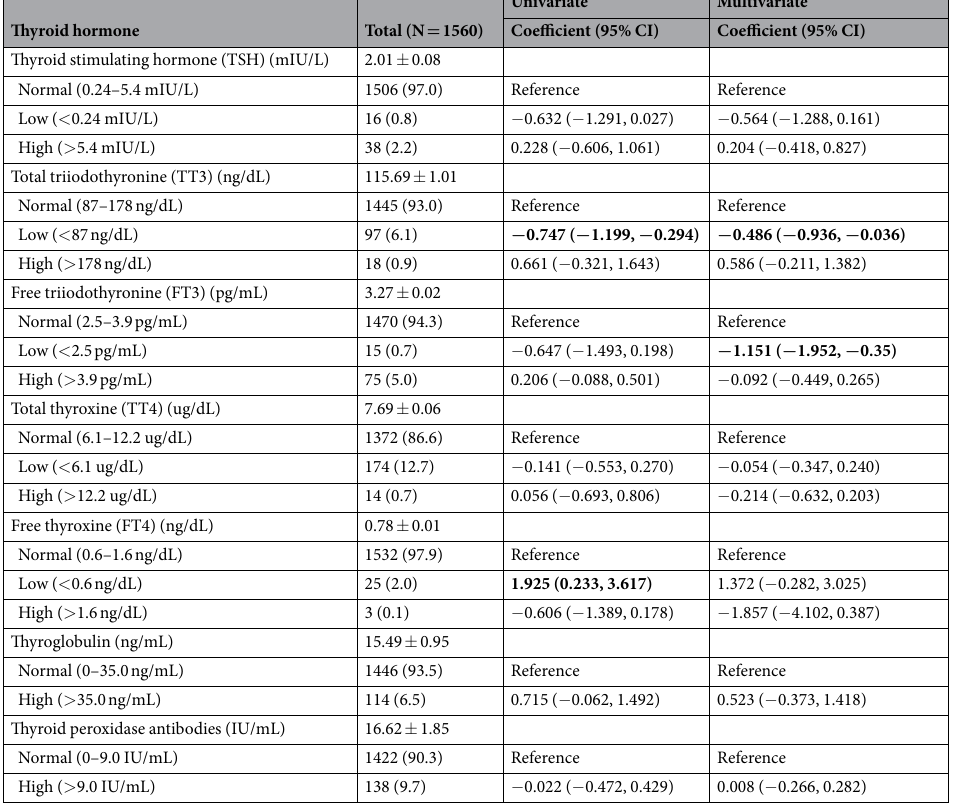
Table 2. Relationship between thyroid hormone levels and insulin resistance. CI, confidence interval. Bold indicates significant factor, p < 0.05. Thyroid hormone levels were shown mean ± standard error; thyroid hormone group numbers were shown unweighted counts (weighted %). Multivariate model: Adjusted for thyroid hormones, race, liver function, depression, obesity, hypertension, dyslipidemia, smoking, physical activity, vigorous recreational activity, moderate recreational activity, 2-hour glucose, glycohemoglobin, high- density lipoprotein, triglyceride, vitamin D, and C-reactive